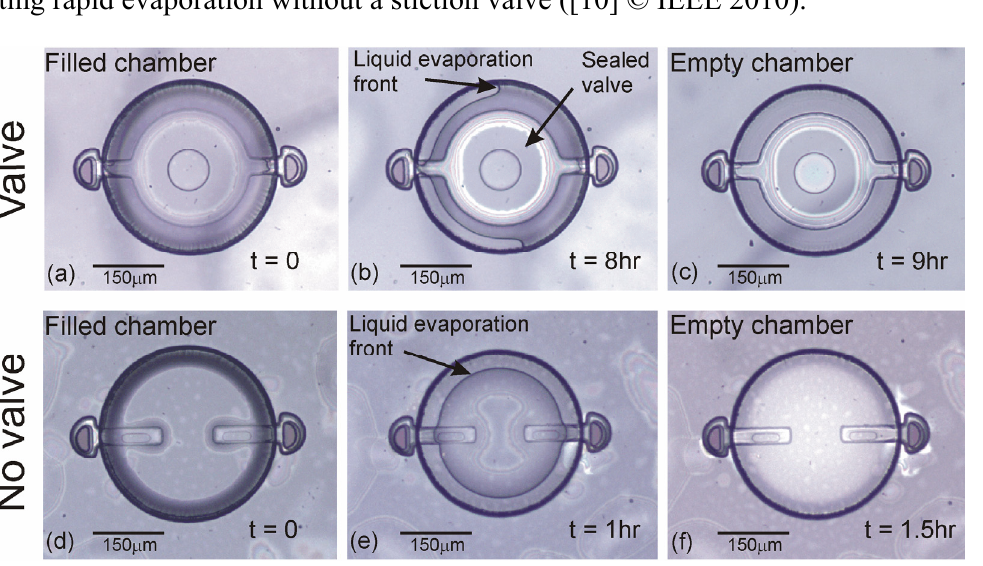
Figure 6. Sequence of optical micrographs depicting the chamber state from filled to empty conditions. (a) Completely filled chamber with valve immediately after removal from immersion bath. (b) Valved chamber after 8 h of evaporative drying at ambient conditions. Complete valve seal evidenced by interference rings and darker central annular region. (c) Empty chamber at 9 h. Valve remains pinned to the substrate. (d) Chamber without valve immediately after removal from immersion bath. (e) Chamber drying occurs rapidly; liquid evaporation front appears at 1 h. (f) At 1.5 h, the chamber is completely dry indicating rapid evaporation without a stiction valve ([10] © IEEE